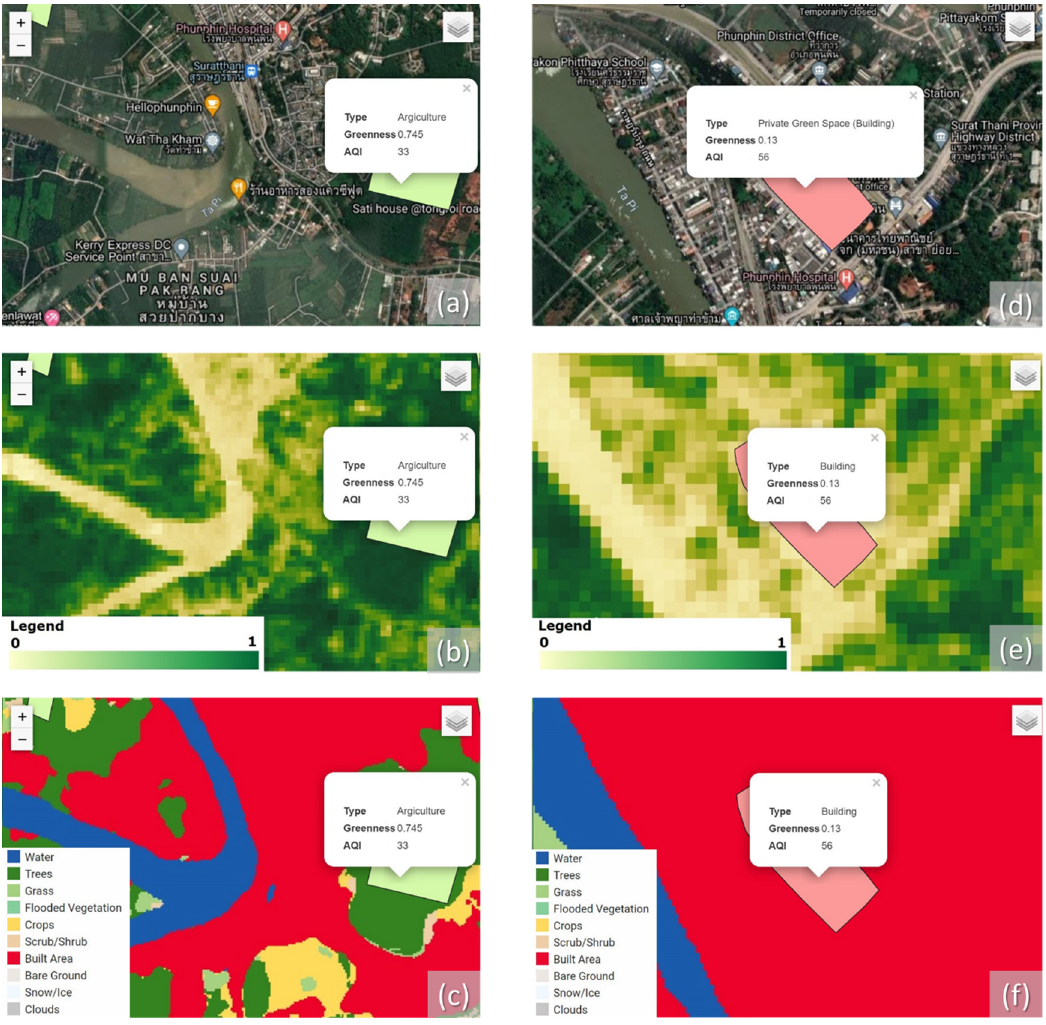
Figure 9. Verifications of green space (left) and non-green space area (right), showing submitted digitization, overlaid on satellite images ( a , d ), greenness results by satellite image analysis ( b , e ), and corresponding LULC data ( c , f ).